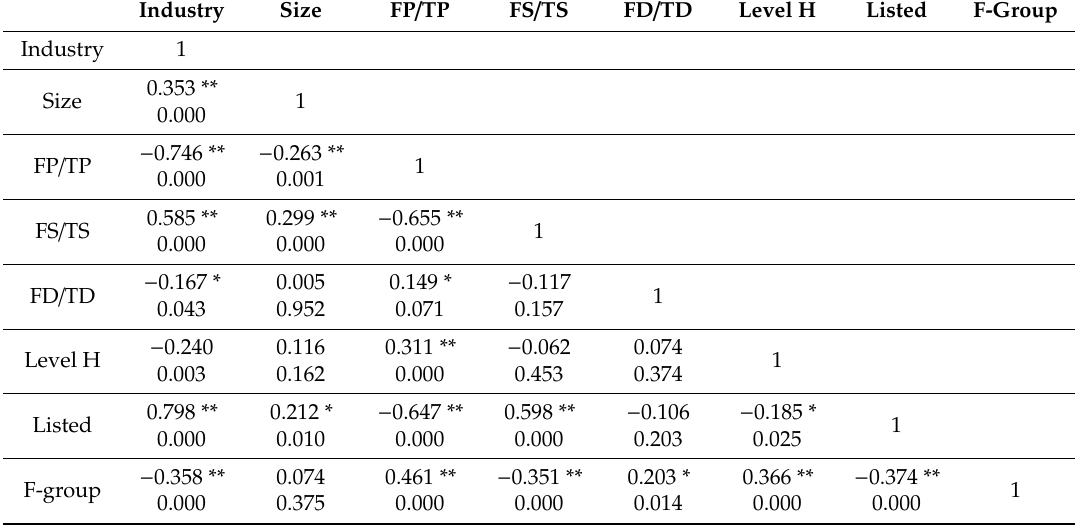
Table 4. Pearson correlation matrix for the dependent and independent variables.